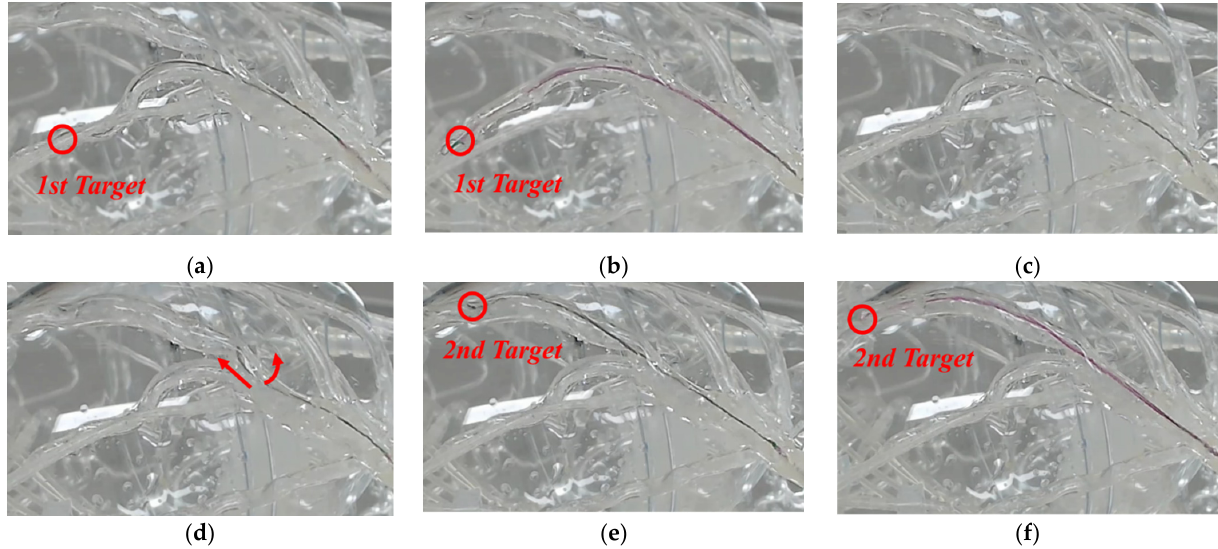
Figure 13. Two-dimensional views of the left coronary artery in the phantom. ( a ) Guidewire is positioned, ( b ) balloon catheter is positioned at the target, ( c ) guidewire is retracted, ( d ) guidewire is advanced, ( e ) it is positioned, ( f ) balloon catheter is positioned at the second target.